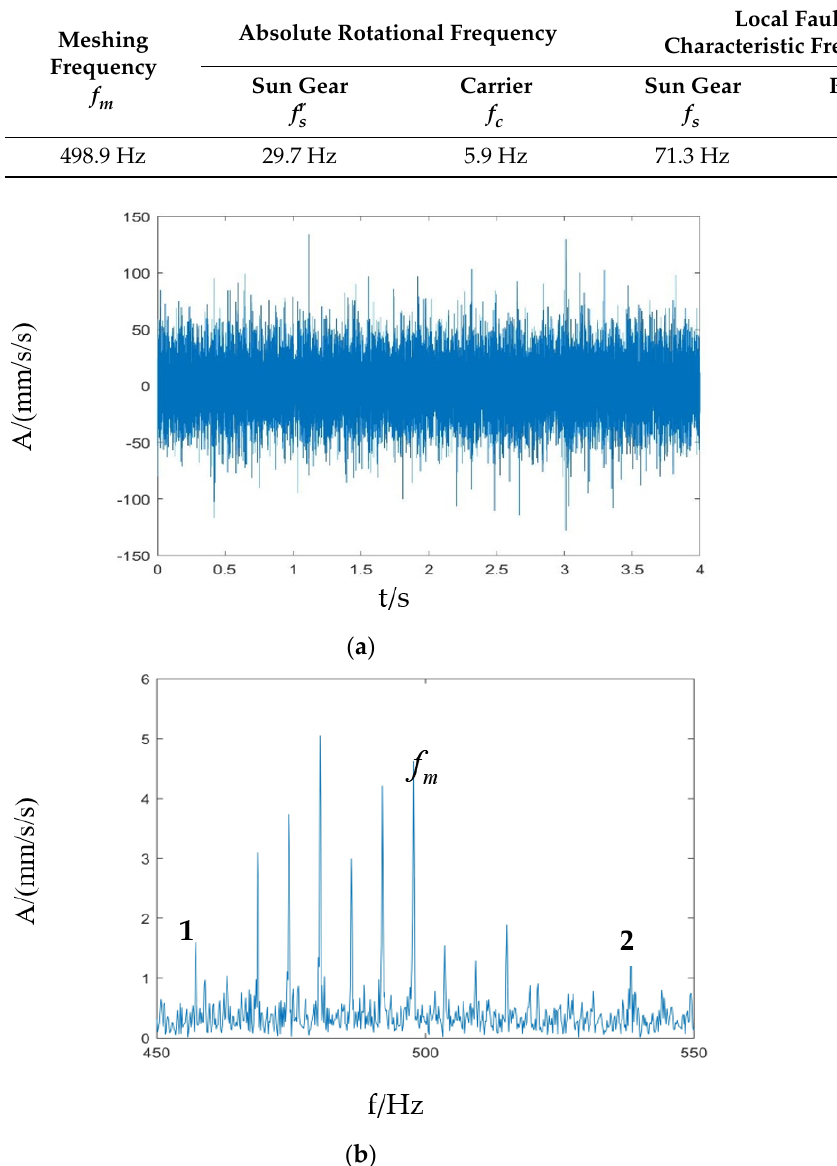
Figure 12. Experimental vibration signal of sun gear and planetary gear under normal working conditions: ( a ) Time domain waveform; ( b ) Fourier spectrum.